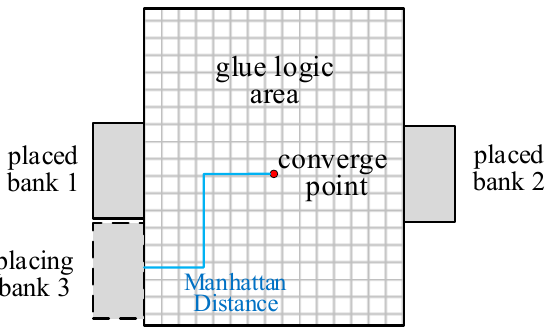
Figure 4. Co-optimization of memory compilation and placement.